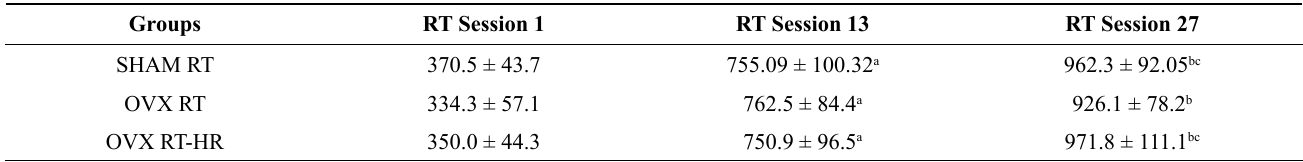
Table 2: Maximal workload (g)